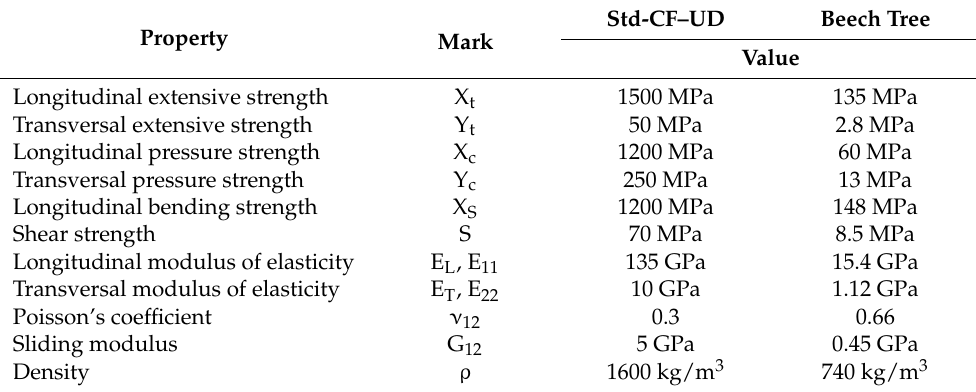
Table 1. Mechanical properties of the composite material Std–CF–UD and beech tree [1]. Std-CF–UD Beech Tree Property Mark Value Longitudinal extensive strength X t 1500 MPa 135 MPa Transversal extensive strength Y t 50 MPa 2.8